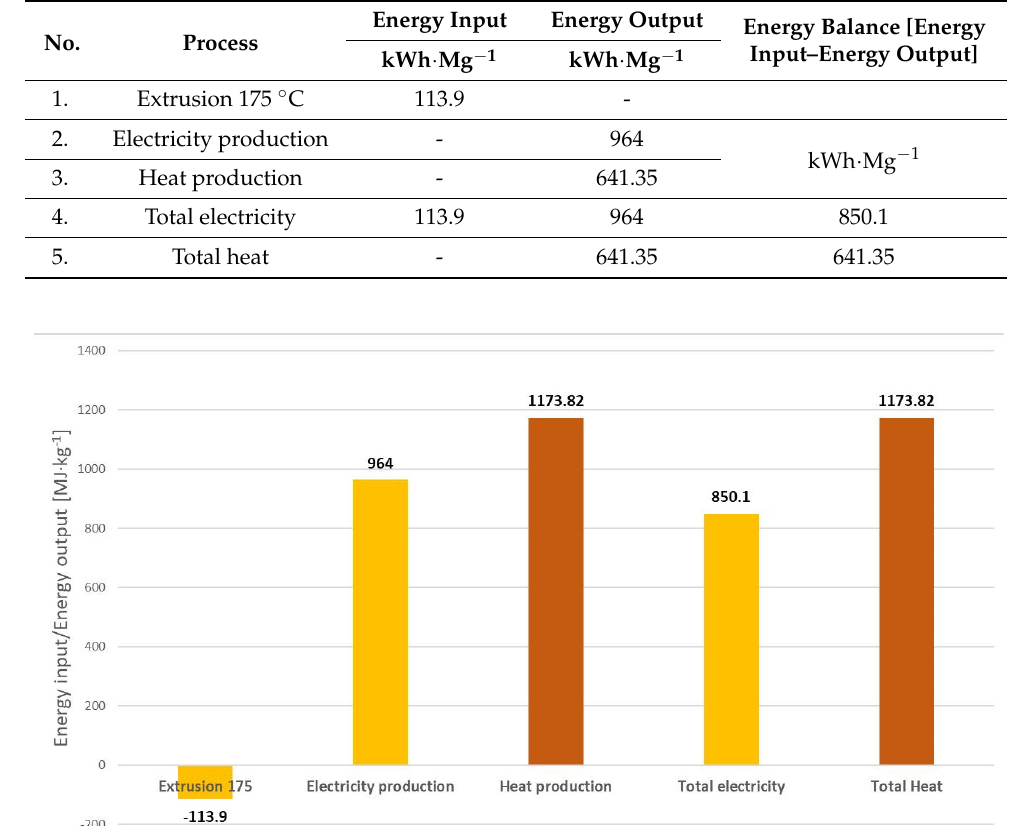
Figure 10. The energy balance of biogas generated from Silphium perfoliatum L. extruded at 175 °C.